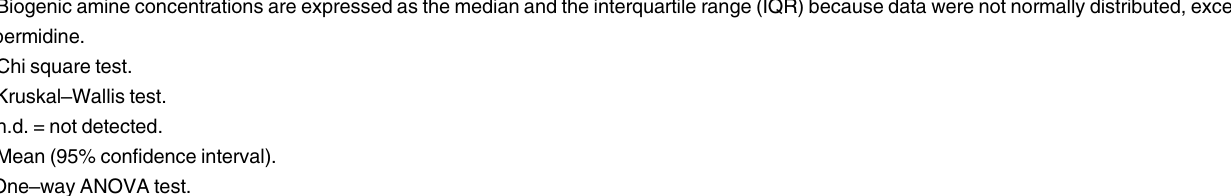
Frequency of Mean max) detection